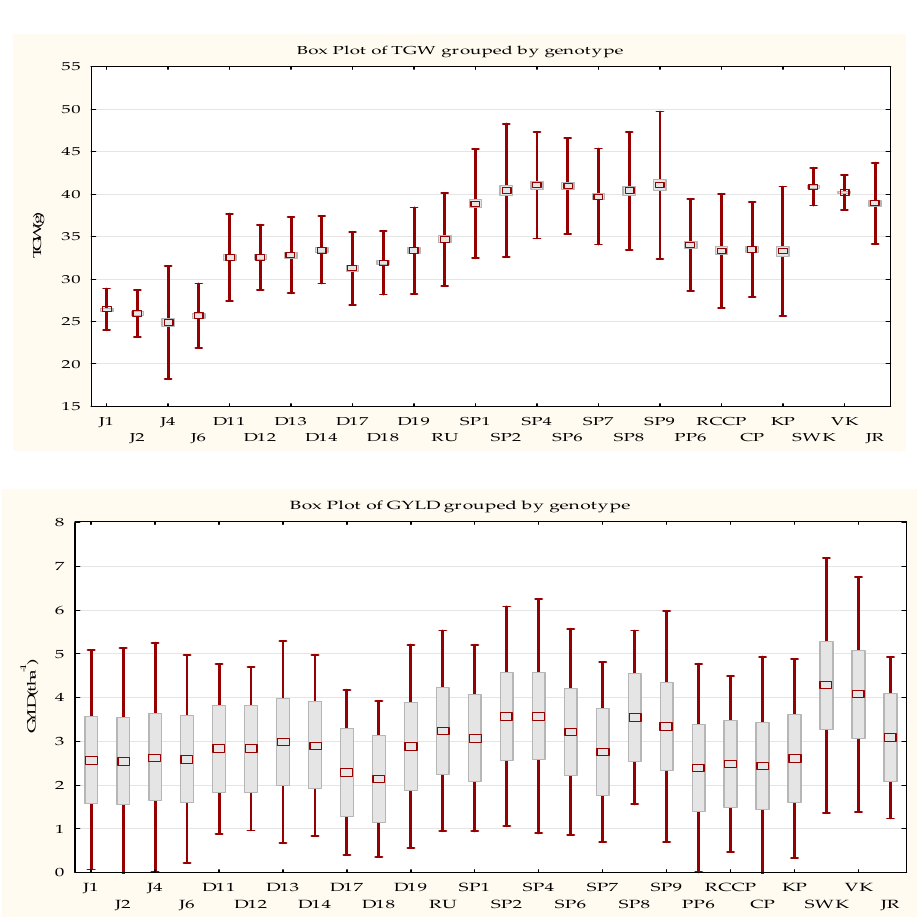
Figure 2. The data show the box plots of thousand grain weight (TGW) and grain yield GYLD, grouped by genotype. The figures are presented as means of 26 wheat varieties grown at three locations, four replications, in four years ( n = 48). Box plots represent the interquartile range; the rectangles in the box symbolize the mean value ± 1, and whiskers designate the minimum and maximum of the box plot.